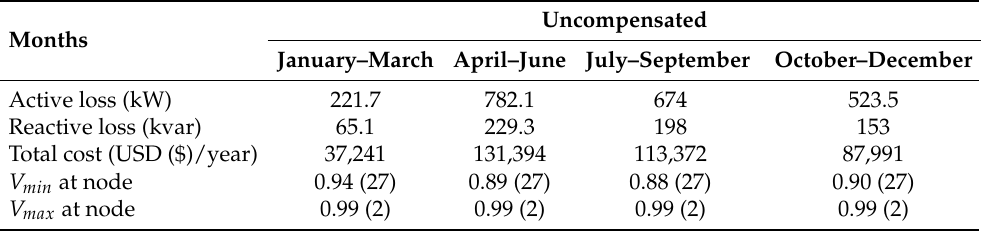
Table 4. Base data (uncompensated) of N 1 for CS 2 .